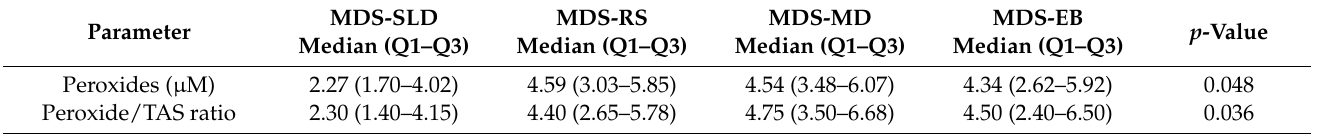
Table 2. Plasma levels of peroxides and peroxide/TAS ratio on myelodysplastic syndrome